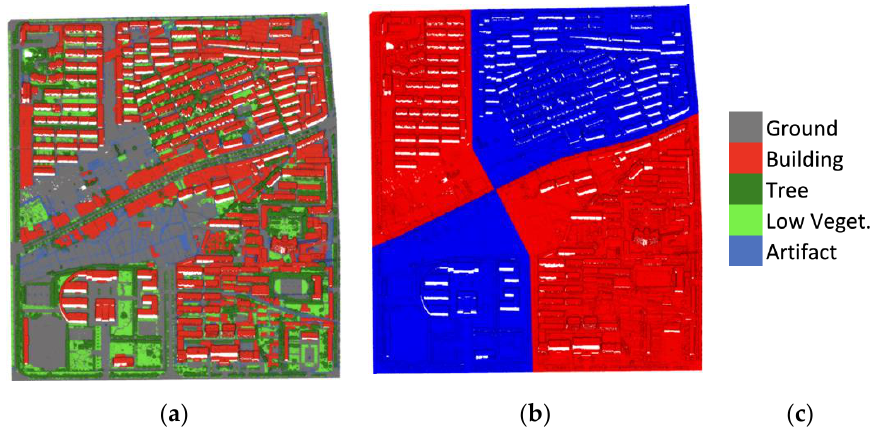
Figure 10. LASDU point cloud with its five classes ( a ). Training (red) and test (blue) sections ( b ). The dataset is divided into sections for training and testing. ( c ) Legend.